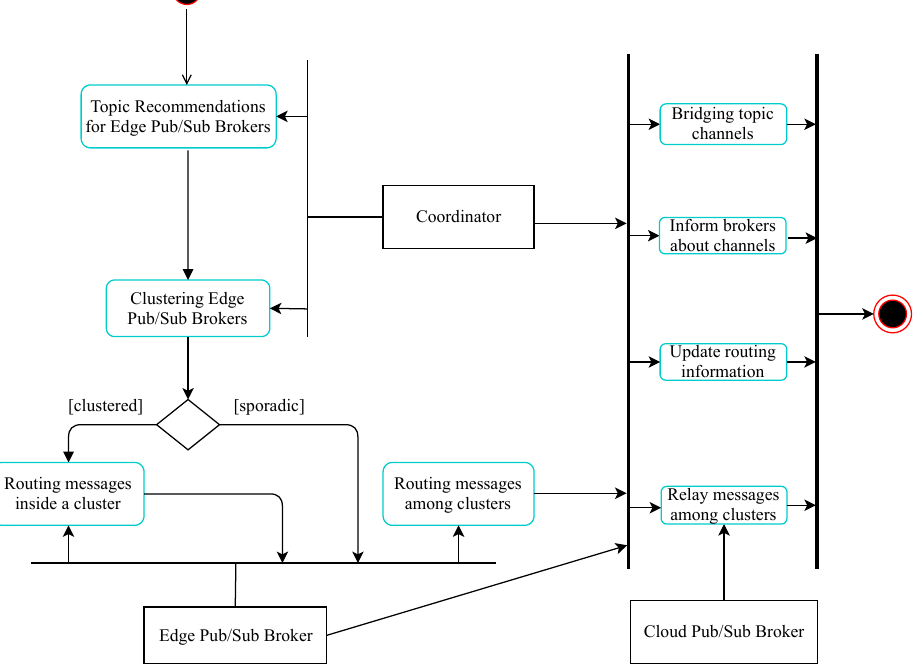
Figure 2. The process for hierarchical data